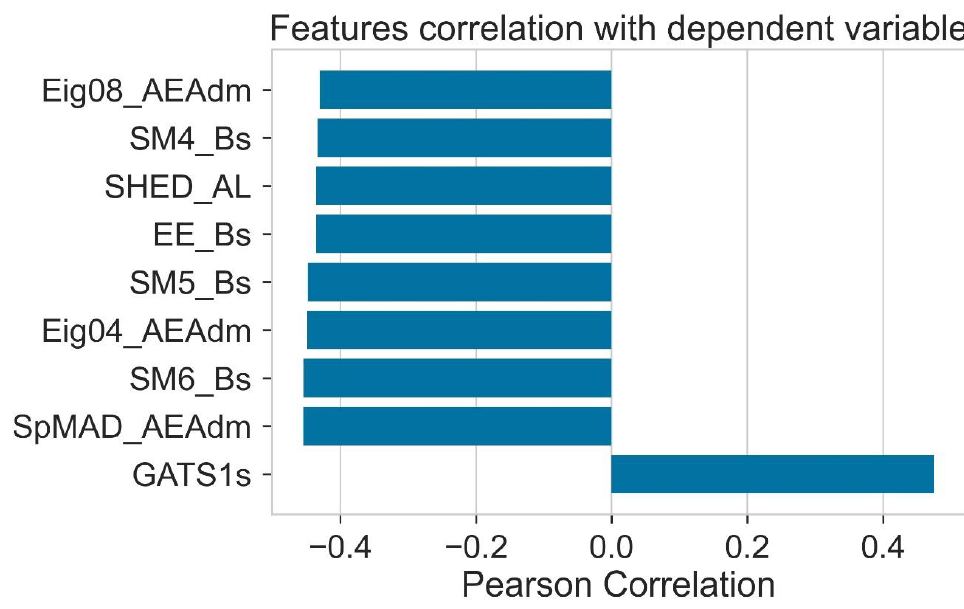
Figure 10. Correlation of features with LUMO.